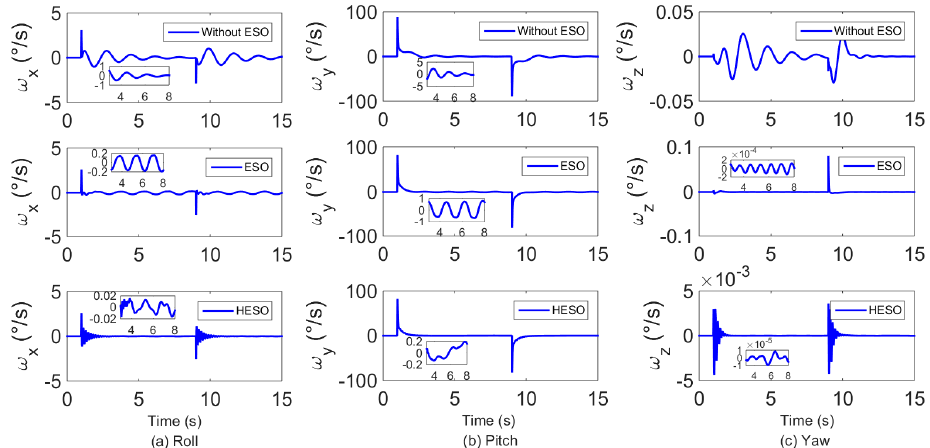
Figure 8. Simulation curves of the attitude rate in attitude tracking: ( a ) roll channel; ( b ) pitch channel; ( c ) yaw channel. Electronics 2018 , 7 , x FOR PEER REVIEW